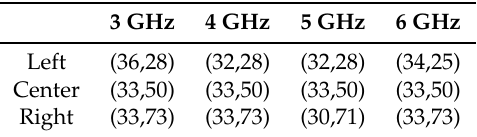
Table 1. The positions of recovered signals at all frequencies.